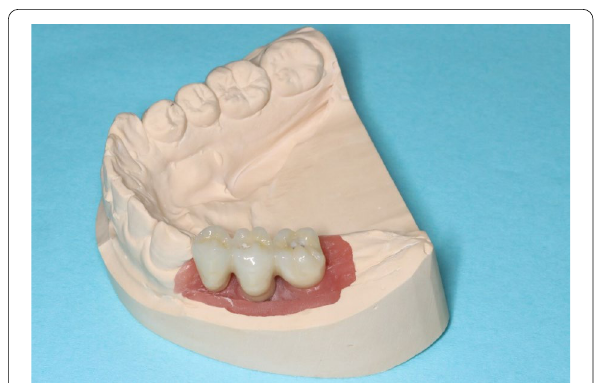
Fig. 7 Fixed partial denture with a zirconia framework